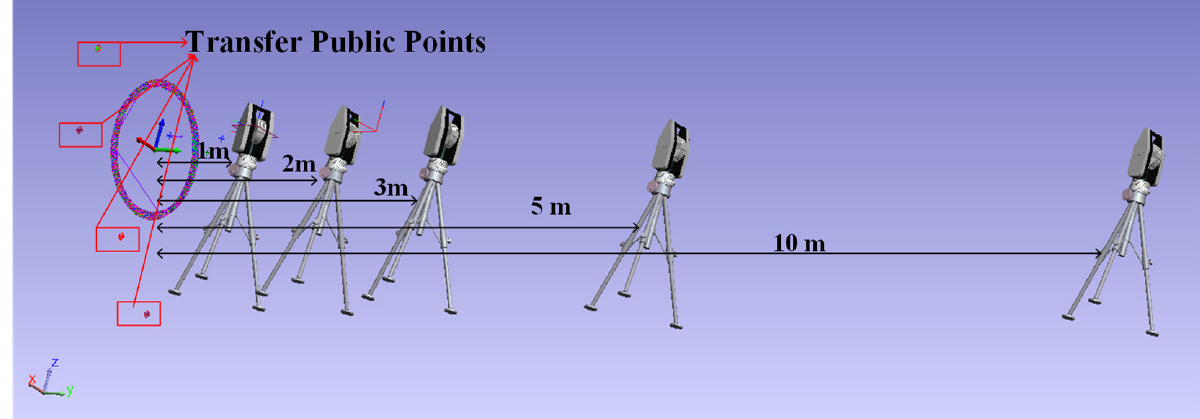
Figure 3. Schematic diagram of the measurement. Table 1 shows the dynamic performance of the laser tracker when measuring at equal spacing. The projection position of sampling points for different measurement intervals is shown in Figure 4. It means that the measurement points were projected in the Y -axis direction for the measurement distance of 1 m. And it is obvious that there is a large amount of data for the measurement intervals of 5 mm and 10 mm. Through data analysis, we drew the following four conclusions: